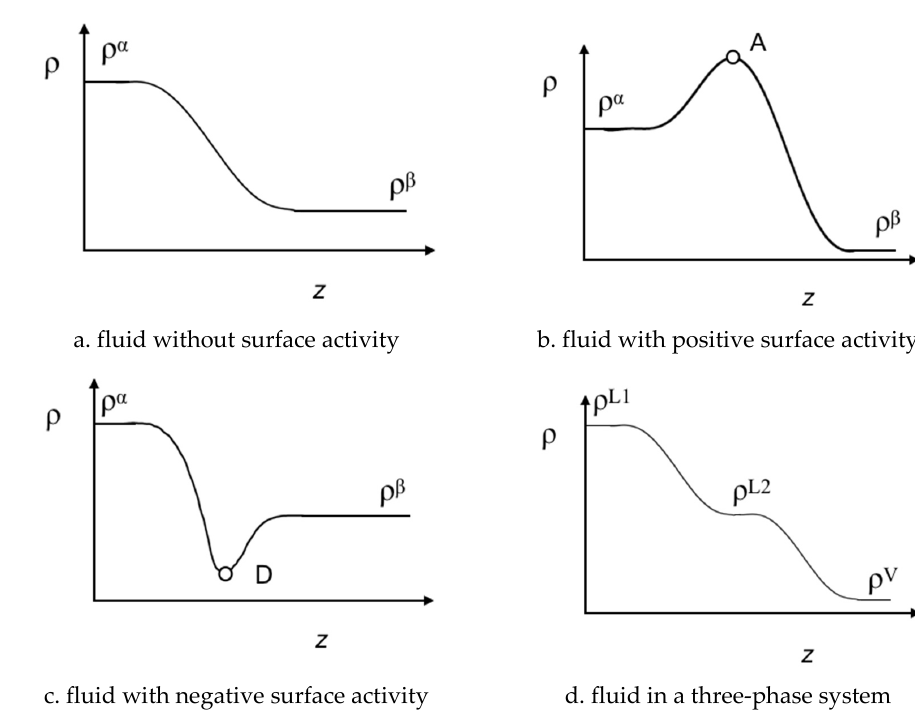
Figure 2. Schematic representation of the multiphasic interfacial concentration profiles, ρ i , as a function of the z coordinate. ( a ) pure fluids or fluid in mixtures without surface activity in a biphasic system; ( b ) fluids with a positive surface activity (adsorption) in a biphasic system; ( c ) fluids with a negative surface activity (desorption) in a biphasic system; ( d ) fluids without surface activity in a triphasic system.